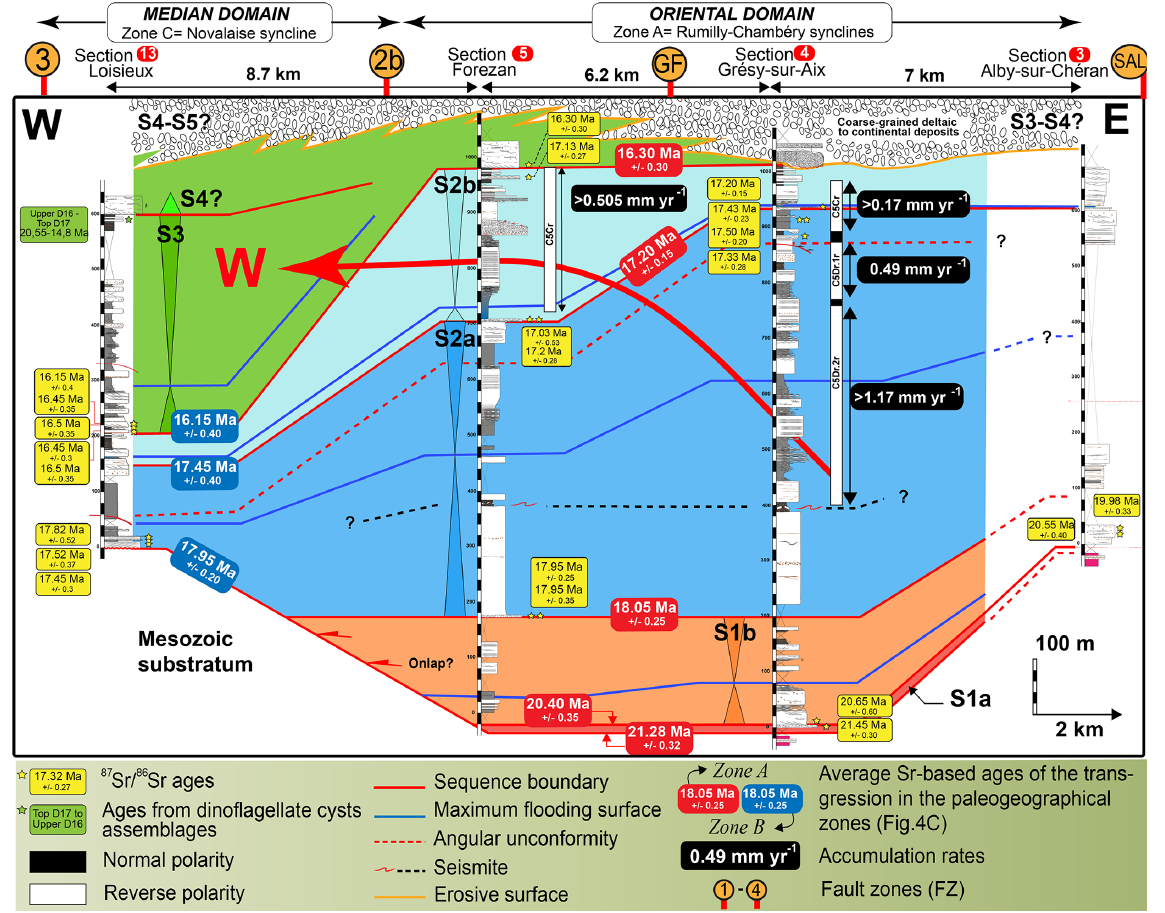
Figure 13. Westward migration of the depocenter during the lower Miocene (red curved arrow). The sedimentological sections were projected on an E–W axis, which corresponds to a direction orthogonal to the thrusts. See Fig. 3 for the location of the transect and sedimentological sections. Red squares: sedimentological sections quoted in the text and used for correlations. The dashed red line corresponds to the angular unconformity presented in Fig.